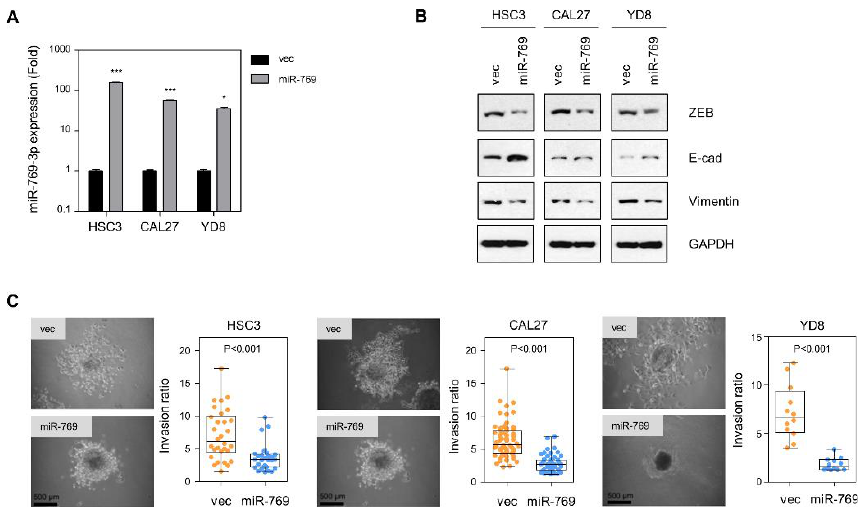
Figure 3. miR-769-3p overexpression decreases EMT protein levels and OSCC cell invasion. ( A ) qRT-PCR of miR-769-3p from CAL27, YD8, and HSC3 cells transduced with miR-769 or empty vectors (vec). The expression levels were normalized to the RNU6B snoRNA level; ( B ) Western blot of ZEB1, E-cadherin, and vimentin from miR-769-3p over-expressing cells. GAPDH was used as loading control. The uncropped blots are shown in File S1; ( C ) spheroid invasion assay using HSC3_vec and HSC3_miR-769-3p cells, CAL27_vec and CAL27_miR-769-3p cells, and YD8_vec and YD8_miR-769-3p cells. Spheroids made from hanging-drop cultures were seeded on collagen gels and then cultured. Spheroid invasion ratios (ratio of whole cell area to central spheroid area) measured using ImageJ. Data represent mean ± SD. P value was determined using two-tailed Student’s t -test. * p ≤ 0.05, *** p ≤ 0.001.